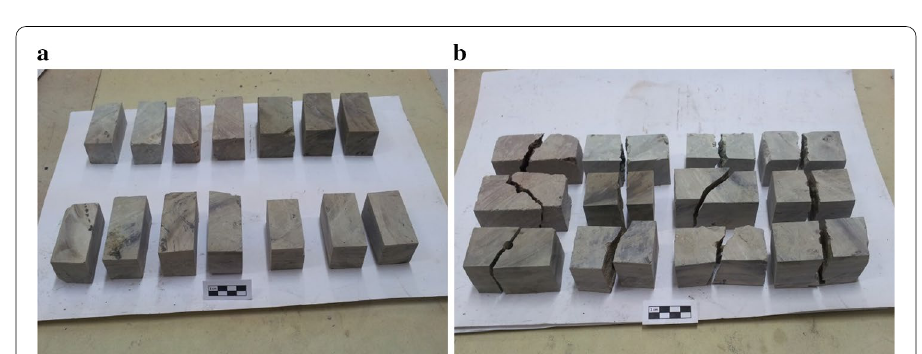
Fig. 4 a Test specimens for point load test, and b few failed samples